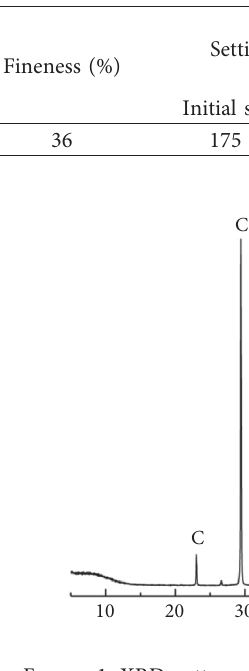
Figure 1: XRD patterns of calcium oxide expansion agent